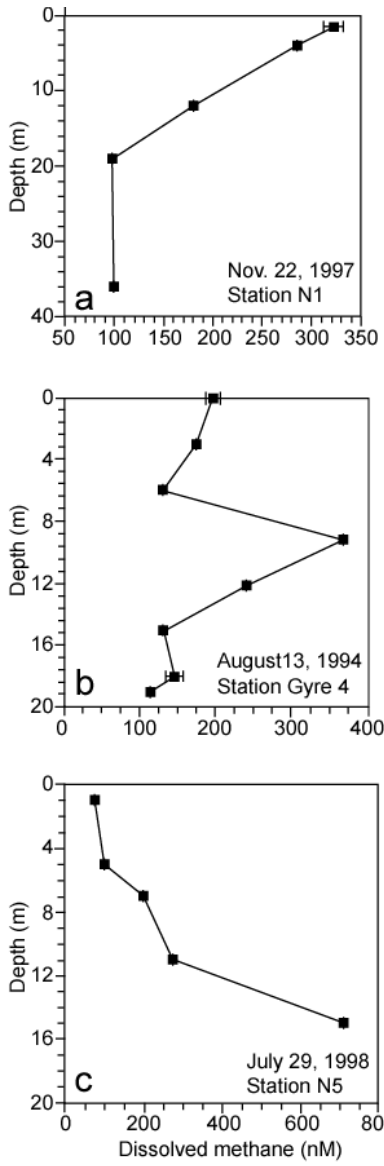
Fig. 10. Vertical profiles of CH 4 at three stations located over the shelf in the region affected by the Mississippi plume in the Gulf of Mexico. Modified from Kelley